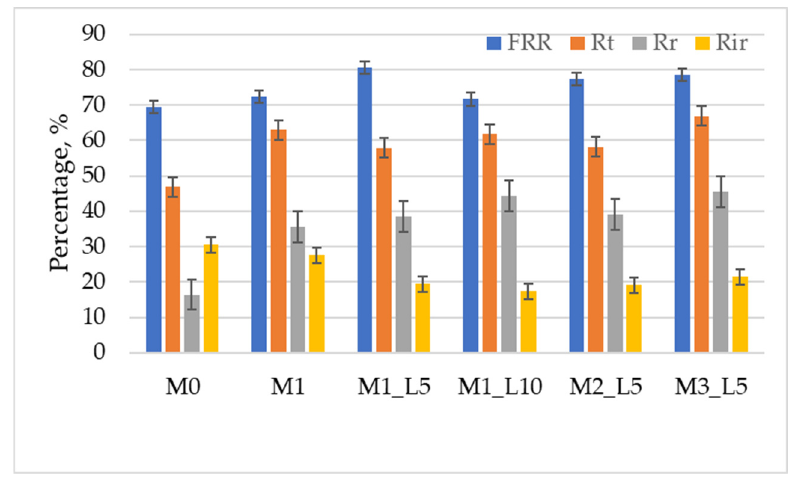
Figure 4. Fouling parameters of membranes with BSA as pollutant.